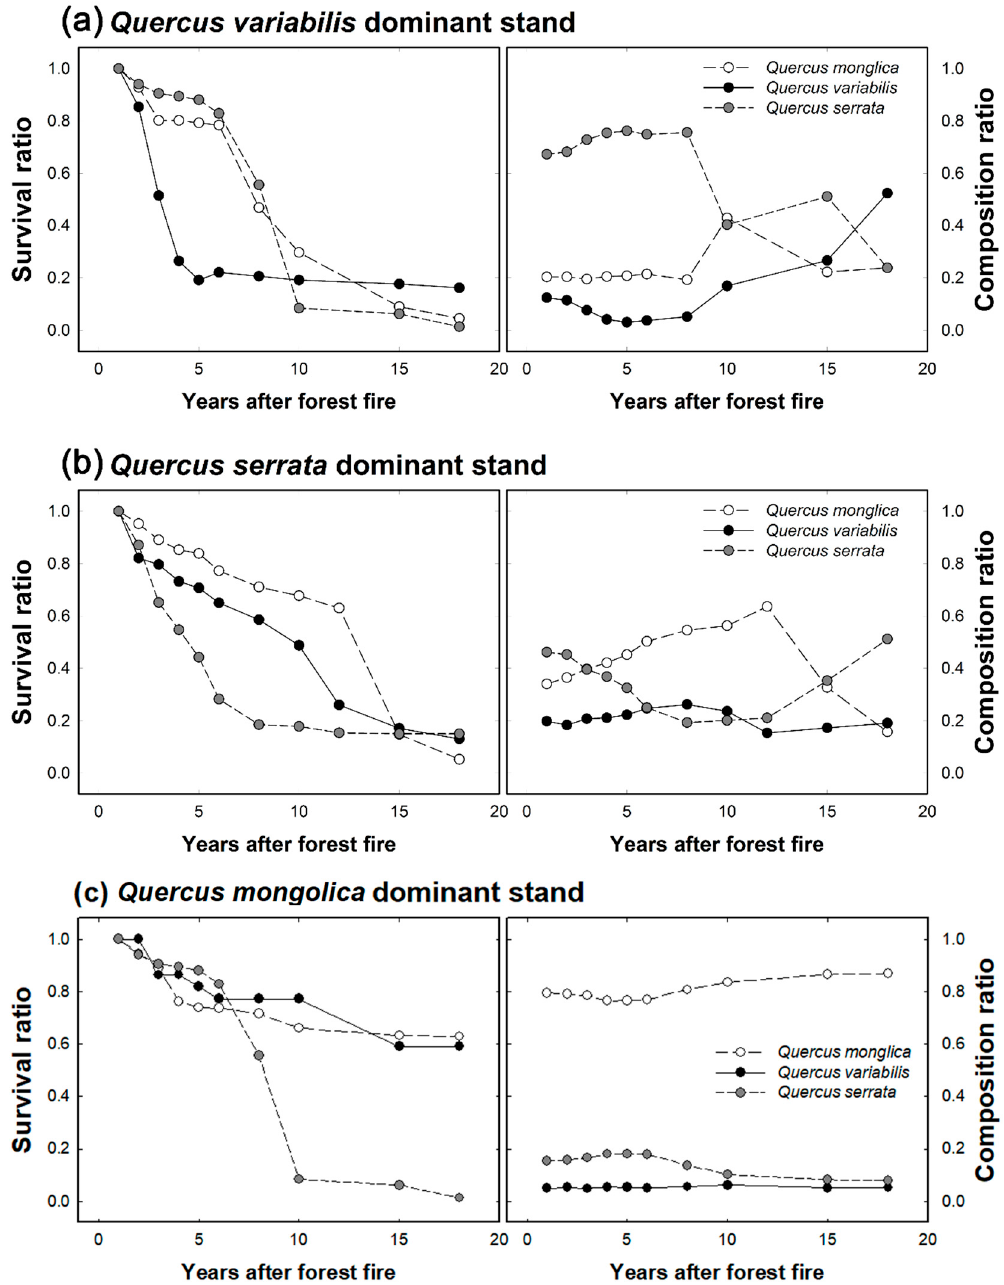
Figure 3. The survival ratio and composition ratio of ( a ) Quercus variabilis (oriental oak), ( b ) Quercus serrata (glandbearing oak) and ( c ) Quercus mongolilca (Mongolian oak) dominant stand during the 18 years after the forest fire.